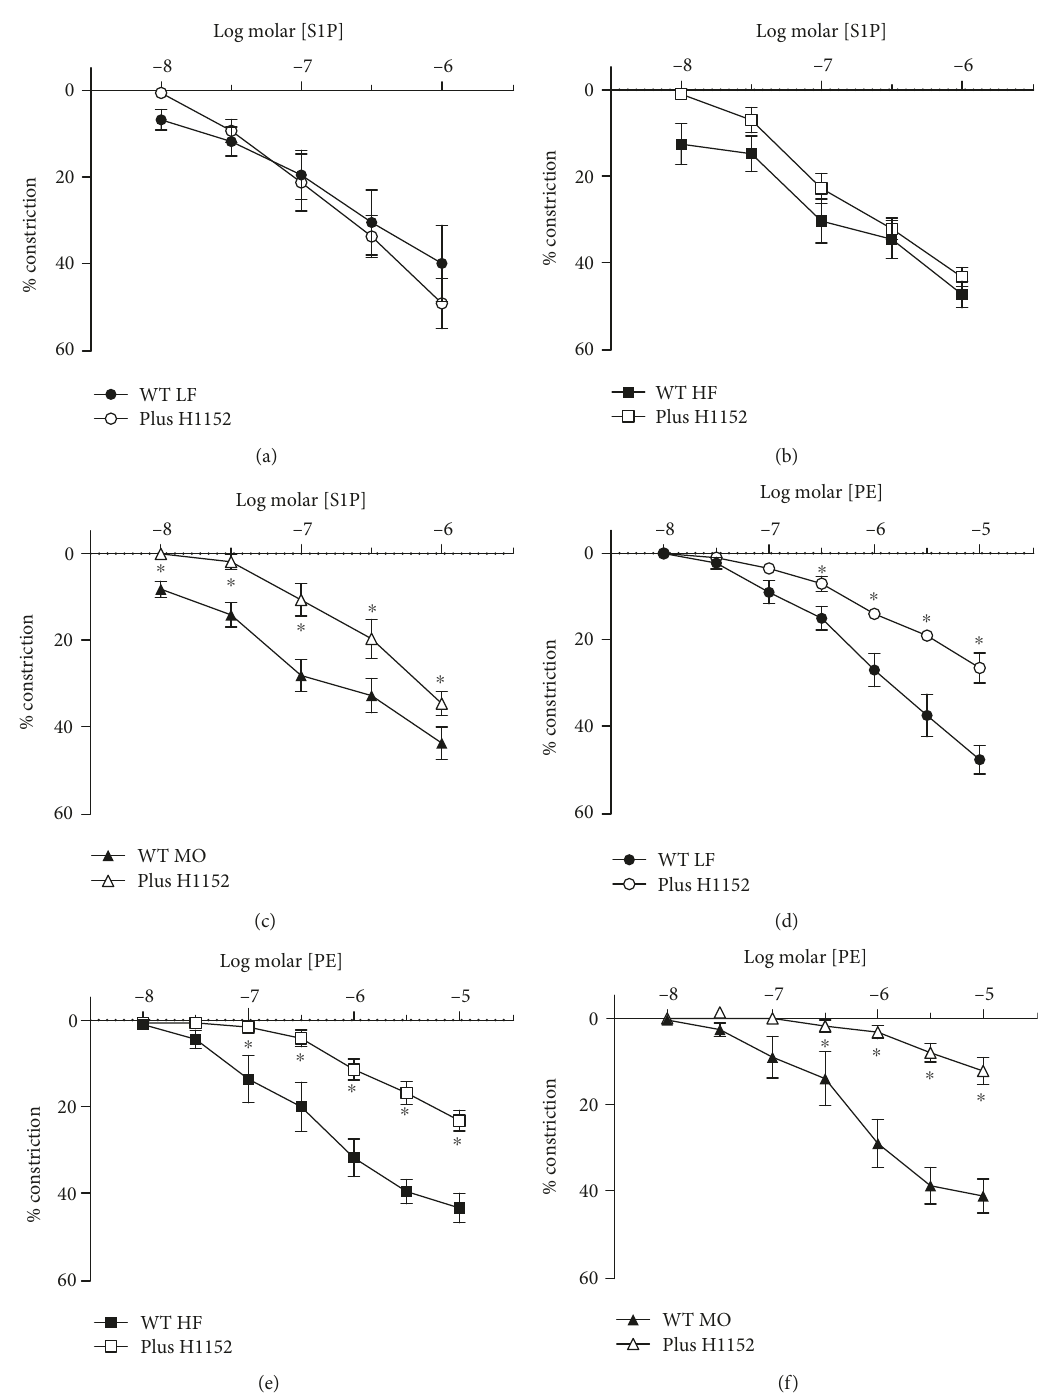
Figure 3: Constriction of gracilis arteries from WT mice on LF ((a, d), n = 4 each), HF ((b, e), n = 5 each), and MO ((c), n = 6 and (f), n = 5 ) diets to S1P (a-c) or PE (d-f) before and after inhibition of rho kinase with H1152 (1 μ M). Mean ± SEM , ∗ p < 0 05 vs. without H1152. Two- way repeated-measures ANOVA followed by Sidak ’ s multiple comparison